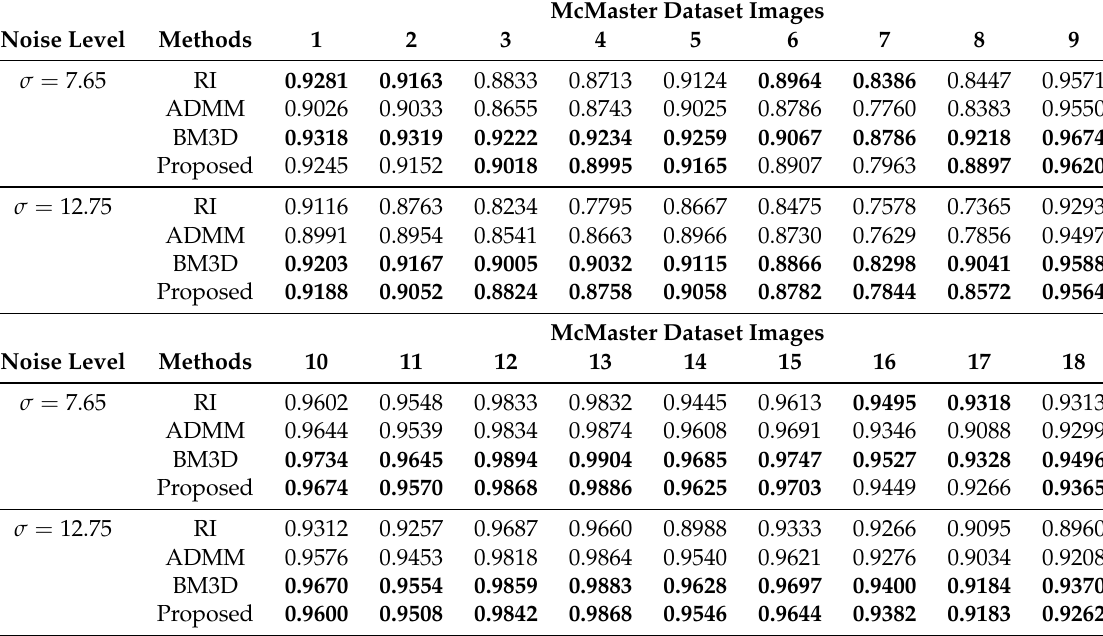
Table 3. Comparison of the SSIM between the different methods. The two best values are in bold